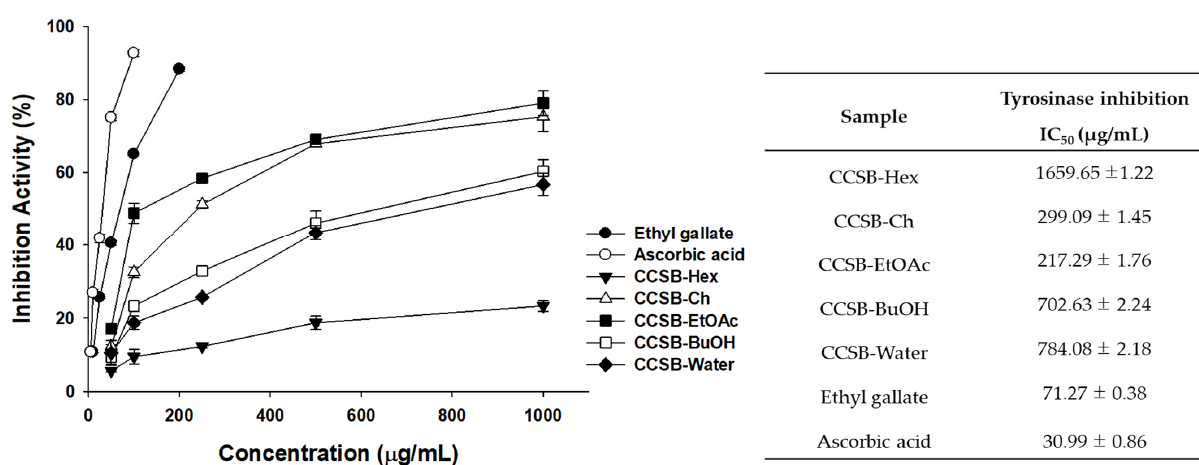
Figure 4. Component analysis of C. cuspidata var. sieboldii branch EtOAc fraction by HPLC MS/MS.